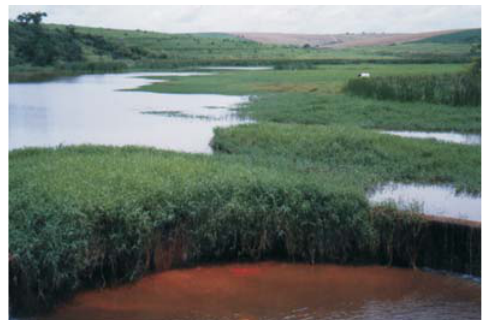
Figura 11. Aspecto de assoreamento em represa localizada na área de estudo (Piracicaba, SP), nas proximidades do Distrito de